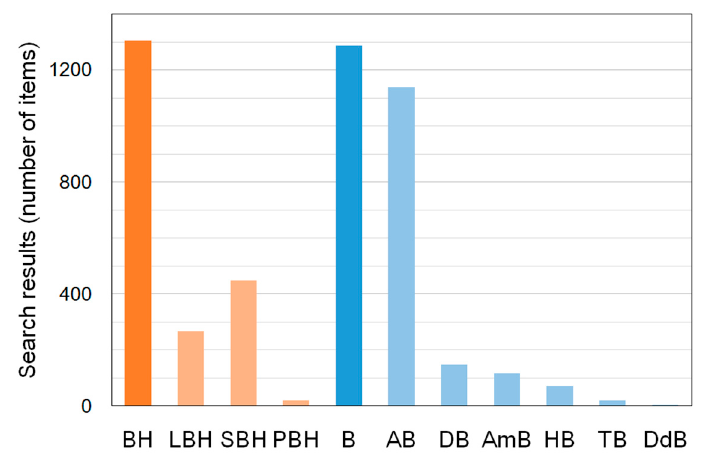
Figure 1. Number of results for a bibliometric resource search made on the Web of Science website the 1st of June 2020. The search was based on the combination: “X” AND “hydrogen storage”, where X is borohydride (BH), lithium borohydride (LBH), sodium borohydride (SBH), potassium borohydride (PBH), borane (B), ammonia borane (AB), diborane (DB), amidoboranes (AmB), hydrazine borane (HB), triborane (TB) and dodecaborane (DdB).